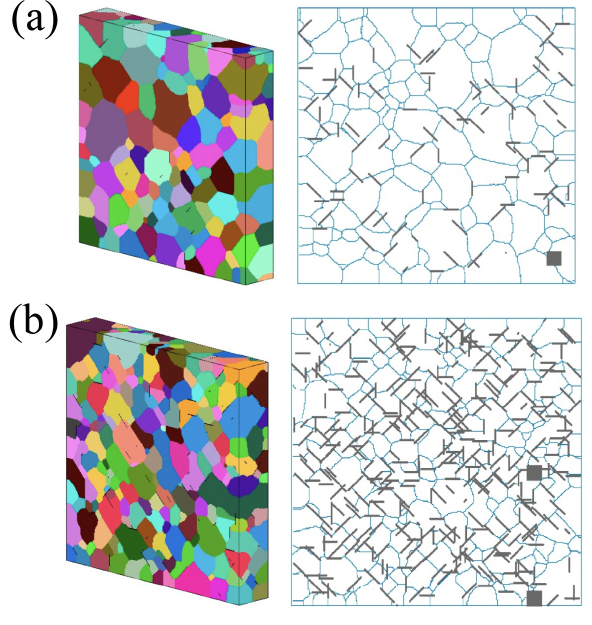
Figure 3. The 3D and 2D cross-sectional microstructures of the Al MMC with the distribution of graphene flakes: ( a ) 1 wt.% and 15 µ m of graphene, ( b ) 4.5 wt.% and 15 µ m of graphene. Reprinted with permission from